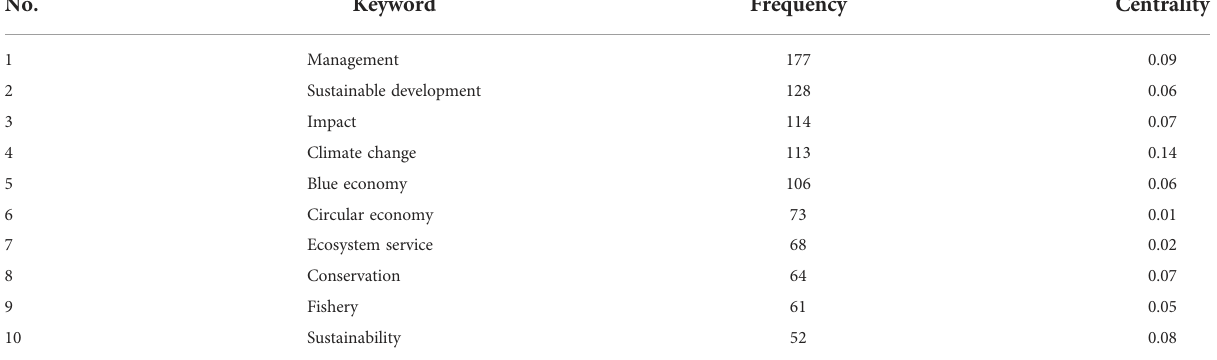
TABLE 9 List of keyword frequencies and their centrality.